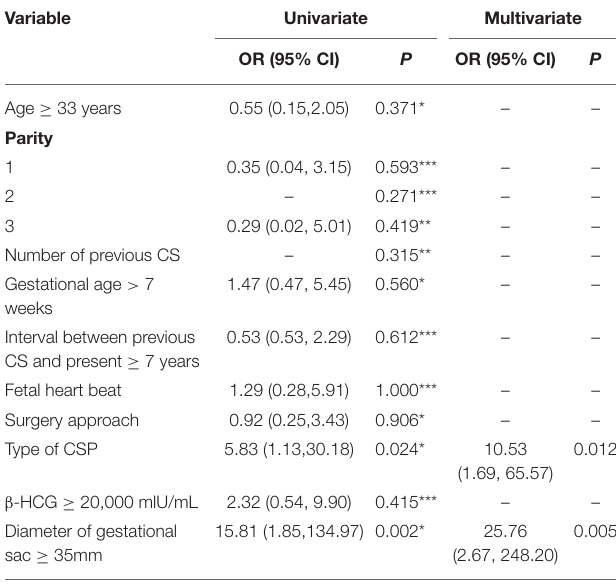
TABLE 5 | Univariate and multivariable analysis of risk factors associated with intraoperative hemorrhage in CSP patients. Variable Univariate